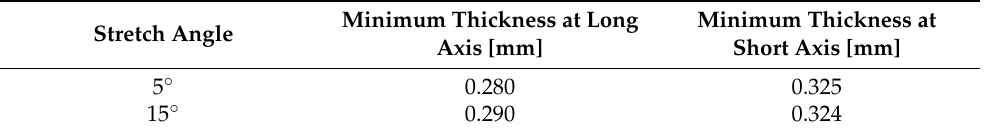
Table 3. Minimum thickness